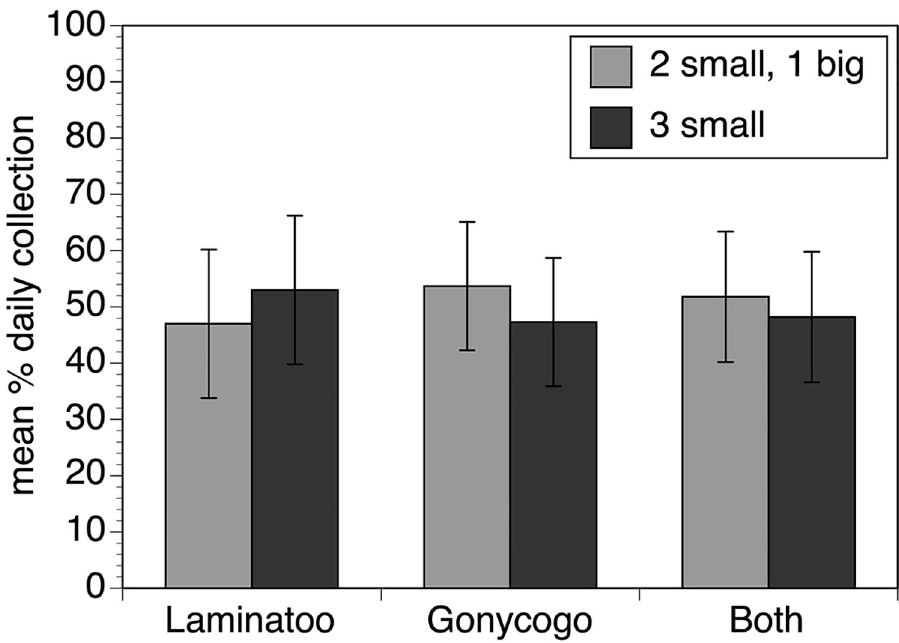
Fig 3. Relative performance of three trap batteries containing three 1m square traps versus two 1m square traps flanking a 1.5m square trap. Bars represent the relative performance of the different trap combinations in Laminatoo, Gonycogo and data from both communities combined. Data are presented as the mean percentage of the total collection by day, normalizing for variations in the absolute number of flies collected on each day, as described in Materials and Methods. Error bars indicate the standard deviation associated with the means. The analysis from Laminatoo incorporated data collected from 18 paired trials, while the analysis from Gonycogo included data collected from 24 paired trials. Raw collection data for this study may be found in the S2